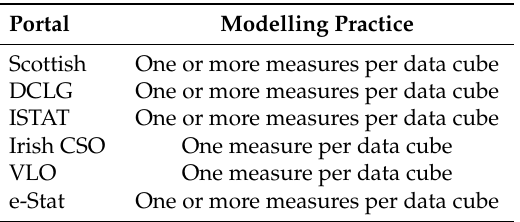
Table 20. Modelling practices of data portals for multiple measures.